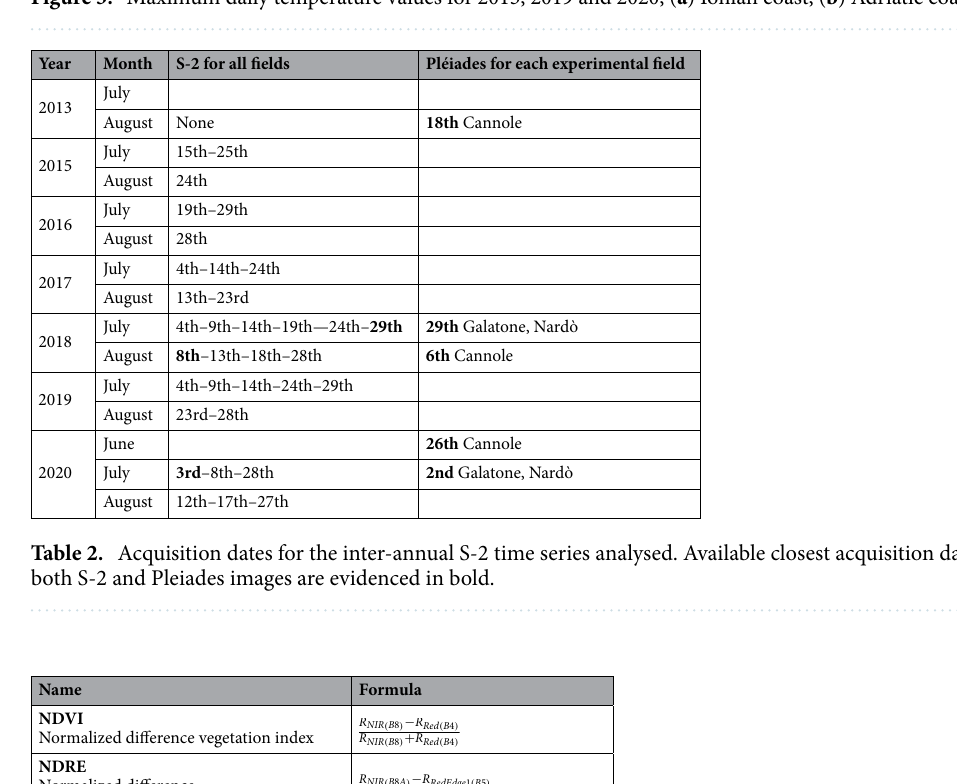
Figure 3. Maximum daily temperature values for 2013, 2019 and 2020, ( a ) Ionian coast; ( b ) Adriatic coast.